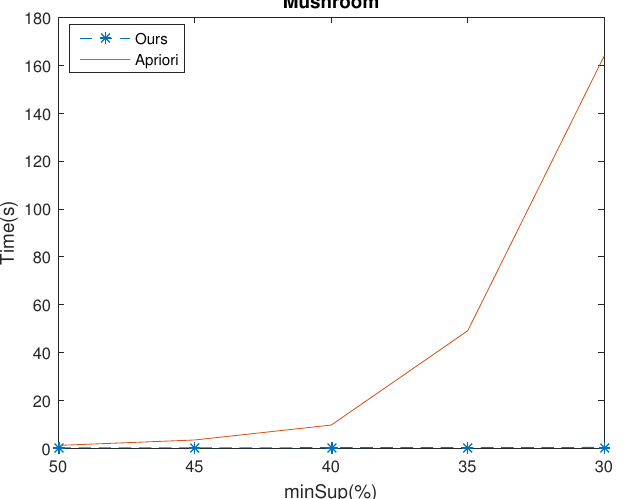
Figure 6. Execution time of the two algorithms in Mushroom dataset for various minSup values.